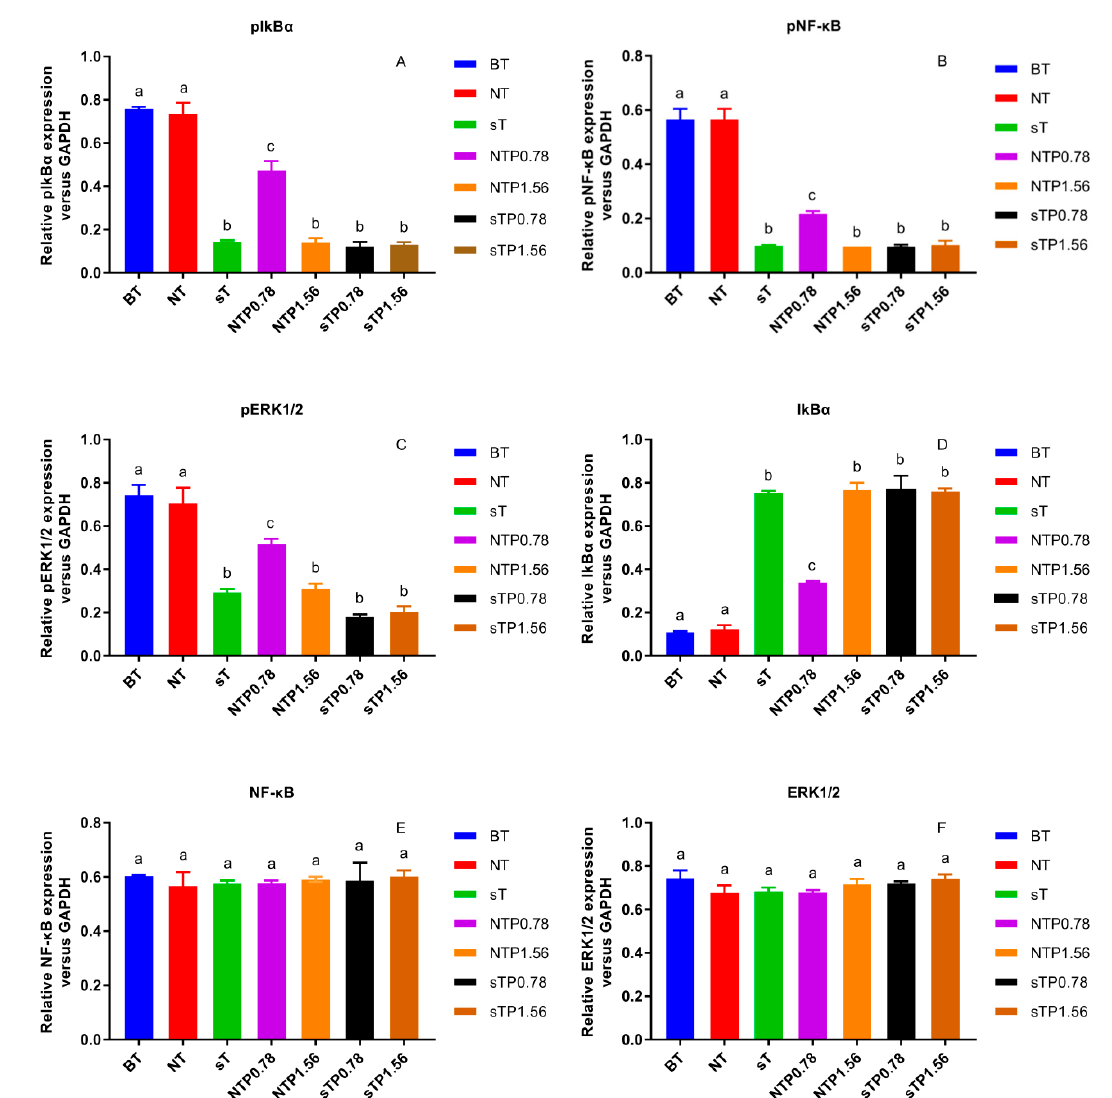
Figure 7. Effect of CP4 on relative protein expression in normal and cyclooxygenase-2 (COX-2) silencing human colon adenocarcinoma (Caco-2) cells ( A ) Relative expression of phosphorylation nuclear factor kappa-B inhibitor alpha (pIkB α ), ( B ) Relative expression of phosphorylation nuclear factor kappa-B (pNF- κ B), ( C ) Relative expression of phosphorylation extracellular signal-regulated kinase 1/2 (pERK1/2), ( D ) Relative expression of IkB α , ( E ) Relative expression of NF- κ B, ( F ) Relative expression of ERK1/2. Blank group with TNF- α (BT), normal cell group with TNF- α (NT), COX-2 silenced cell group with TNF- α (sT), normal cell group with TNF- α and 0.78 µ g/mL drug intervention (NTP0.78), normal cell group with TNF- α and 1.56 µ g/mL drug intervention (NTP1.56), COX-2 silenced cell group with TNF- α and 0.78 µ g/mL drug intervention (sTP0.78), COX-2 silenced cell group with TNF- α and 1.56 µ g/mL drug intervention (sTP1.56) were treated with drugs. Values without a common letter were significantly different as p < 0.05.